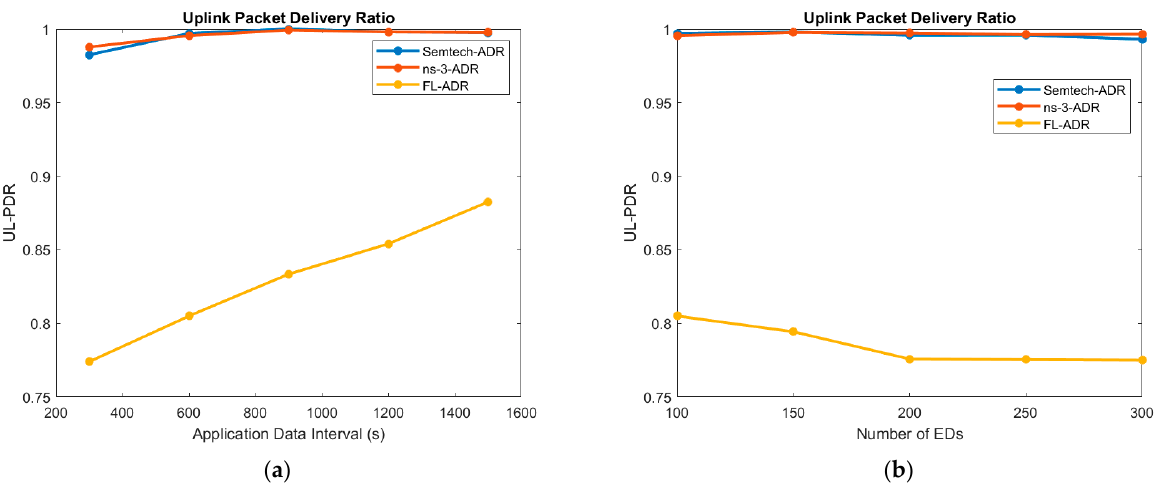
Figure 7. Undersensitivity rate: ( a ) data interval vs. uplink packet delivery ratio; ( b ) no. EDs vs uplink packet delivery ratio.